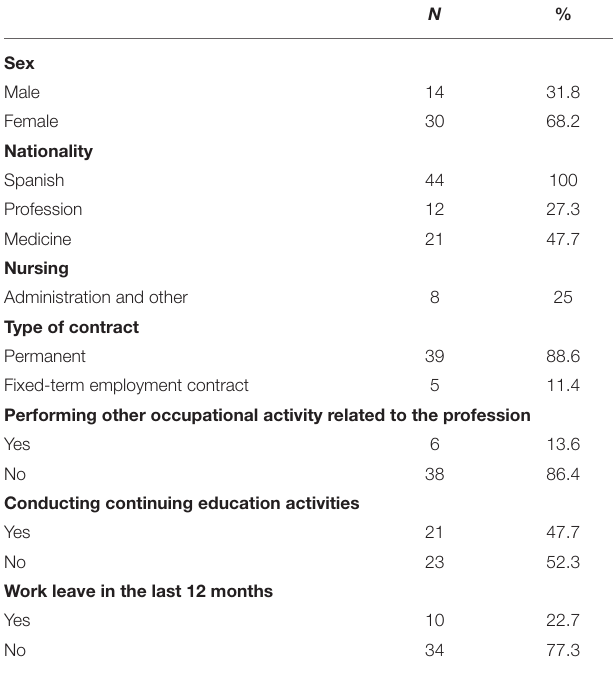
TABLE 1 | Summary of qualitative, sociodemographic and labor